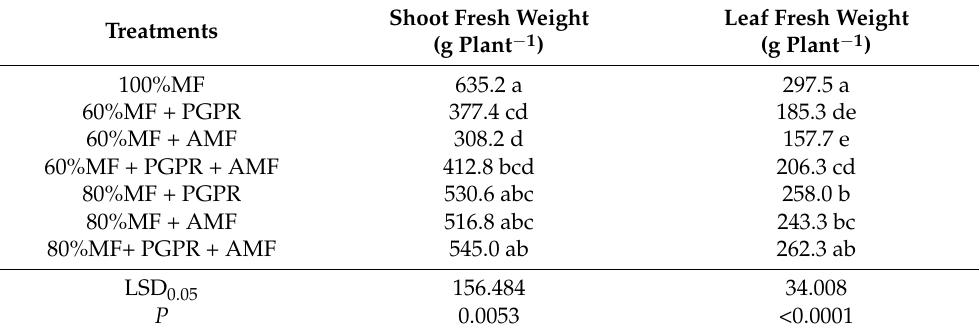
Table 3. Effects of the bio-fertilizers on shoot and leaf weights 164 DAT at the end of the cultivation. Shoot Fresh Weight Treatments